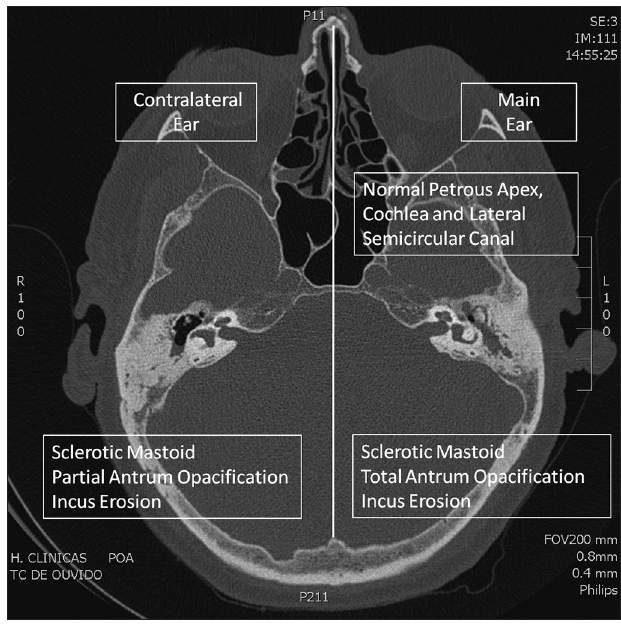
Figure 1. Axial CT Scan. Comparison of abnormalities in the main (left) and contralateral (right)